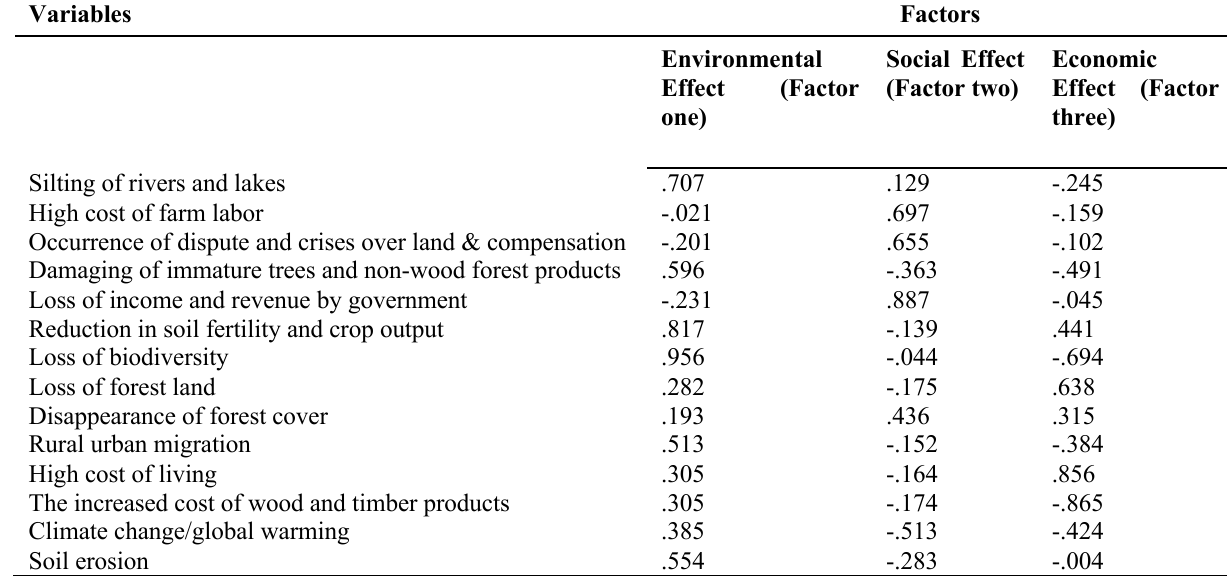
Table 3: Environmental, Economic and Social Effects of Timber Exploitation (Factor analysis table)